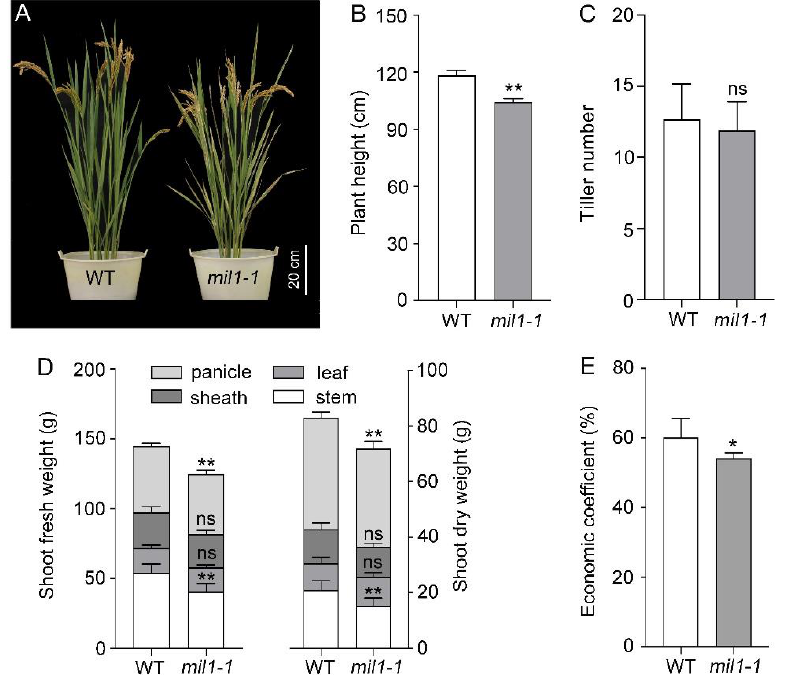
Figure 3. Biomass production in WT and mil1-1 . ( A ) Morphological feature of WT and mil1-1 at mature stage. ( B – E ) Agronomic traits, including plant height ( B ), tiller number ( C ), shoot fresh and dry weight ( D ), and economic coefficient ( E ), in WT and mil1-1 . A two-tailed unpaired t -test with Welch’s correction is used for statistical analysis. Asterisks indicate significant differences between treatments and respective controls at each time point (* p < 0.05, ** p < 0.01; Student’s t test).